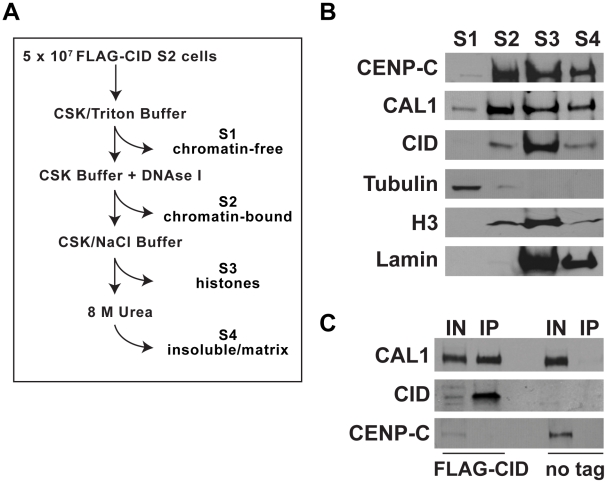
CAL1 and CID interact in chromatin-free extracts.A) Diagram depicting the cell fractionation method. B) Western blots to determine the presence of CAL1, CID and CENP-C in different cellular fractions. Chromatin-free (S1), nuclear-soluble (S2), chromatin-associated (S3) and insoluble/matrix-bound (S4) protein fractions were extracted from S2 cells stably transfected with FLAG-tagged CID. 40 µg of total protein was loaded in each lane. Antibodies against α-Tubulin, histone H3K4Me2 and Lamin were used to track the content of the different fractions (see Materials and Methods). C) Immunoprecipitation showing the specific interaction between FLAG-CID and CAL1 from the S1 fraction. The CID-CAL1 interaction was visible only in extracts from FLAG-CID expressing cells and not from untransfectd S2 cells (no tag). Soluble FLAG-CID did not pull down CENP-C. Chromatin-free extracts were incubated with 10 µl of FLAG-M2 agarose for two hours before elution of the bound CAL1 complex (IP) with 300 µg/ul of 3×FLAG peptide; 25% of the eluted material (IP) and 50 µg input material (IN) were loaded.